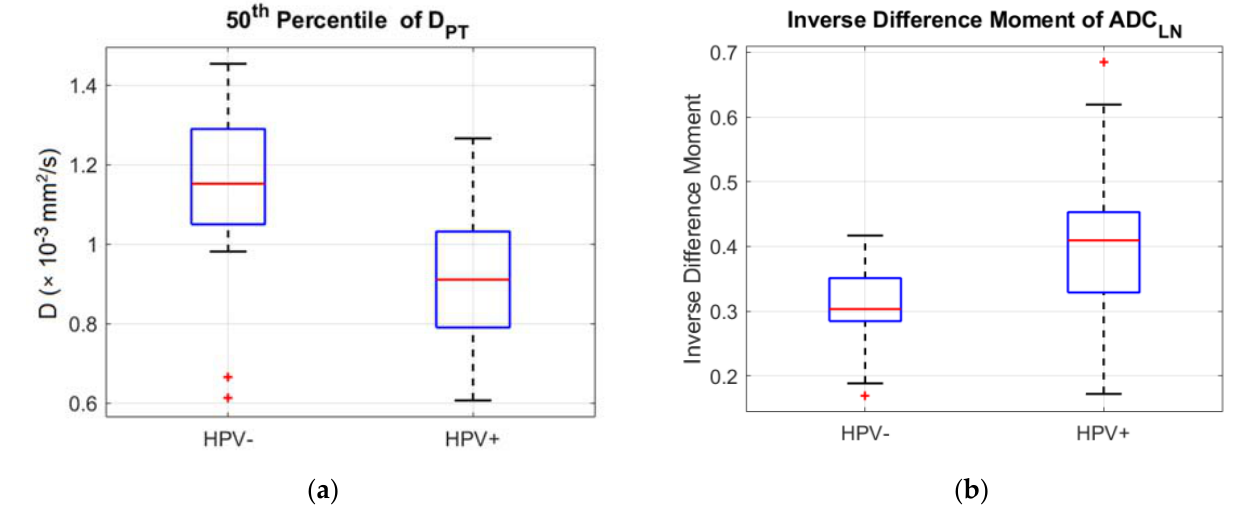
Figure 3. Box ‐ and whisker plot of 50th percentile of D PT ( a ) and Inverse Difference Moment of ADC LN ( b ) sorted by HPV status.